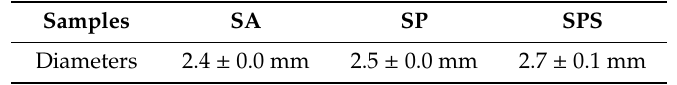
Figure 3. Photographs of the abbreviation of Zhengzhou University, “ZZU”, which was composed of the SA (the first letter “Z”), SA / PEI (SP) (the second letter “Z”) and SPS (the third letter “U”) hydrogel spheres. Table 1. Diameter statistics of the SA, SP and SPS hydrogel spheres (n = 100, mean ±